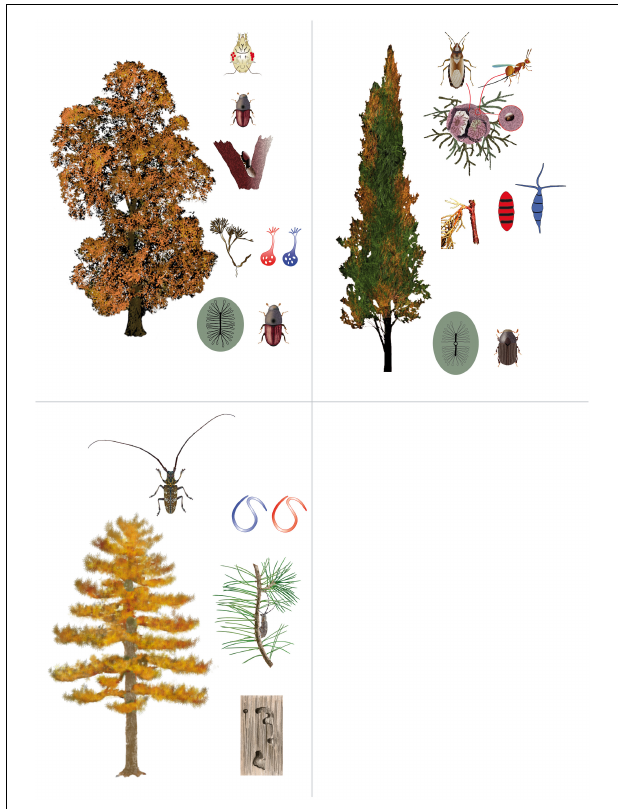
FIGURE 1 | Agents involved in the development of tree pandemics causing dieback of elms (Dutch elm disease), cypress (cypress canker), and pines (pine wood nematode). The non-native, aggressive microorganism is in red color and the native, non-aggressive microorganism in blue color. Elm: elm bark beetles do both bark breeding on main stem and branches, and maturation feeding on twigs, through which they carry the indigenous saprotrophic fungus Ophiostoma quercus (blue) among trees, with the help of phoretic mites that carry the fungus in special parts of the body called mycangia. The introduction of the congeneric O. ulmi s.l. (red), a fungus having niche requirements similar to O. quercus but far more aggressive, caused the almost complete replacement of the endemic fungus. At the same time elm bark beetles and associated mites transport several species of Geosmithia (gray), which seems to have developed a mycoparasitic activity toward O. ulmi s.l. Cypress: cypress bark beetles do both bark breeding and maturation feeding on twigs, through which they carry the indigenous non-aggressive fungus Pestalotiopsis funerea (blue) among trees. The introduction of Seiridium cardinale (red), a fungus having niche requirements similar to P. funerea but far more aggressive, caused the development of